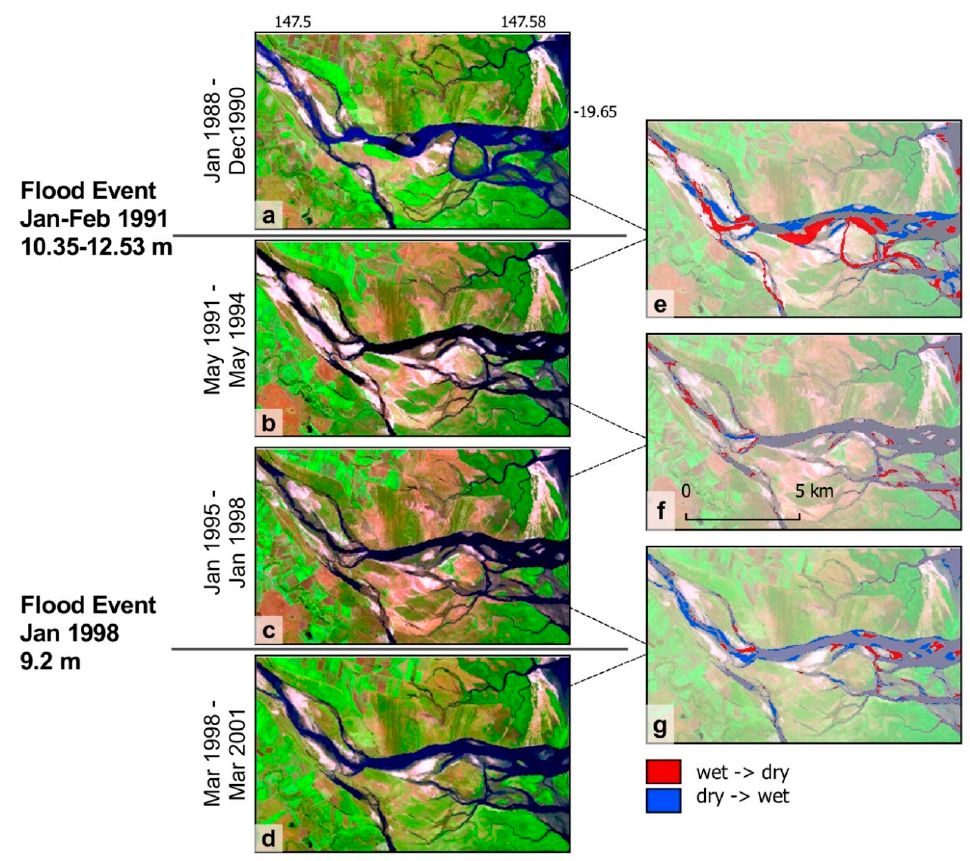
Figure 7. Event based composite generation and change analysis: pixel-based composites generated on either side of identified flood events at the Burdekin River mouth estuary. Produced from observations in the lowest 20th percentile of the observed tidal range (OTR), and displayed in false colour ( a – d ). Change analysis utilising the normalised difference water index (NDWI) ( e – g ) highlights the increased modification of the estuary before and after flood events ( e , g ), in comparison to a non-flooding period ( f ).